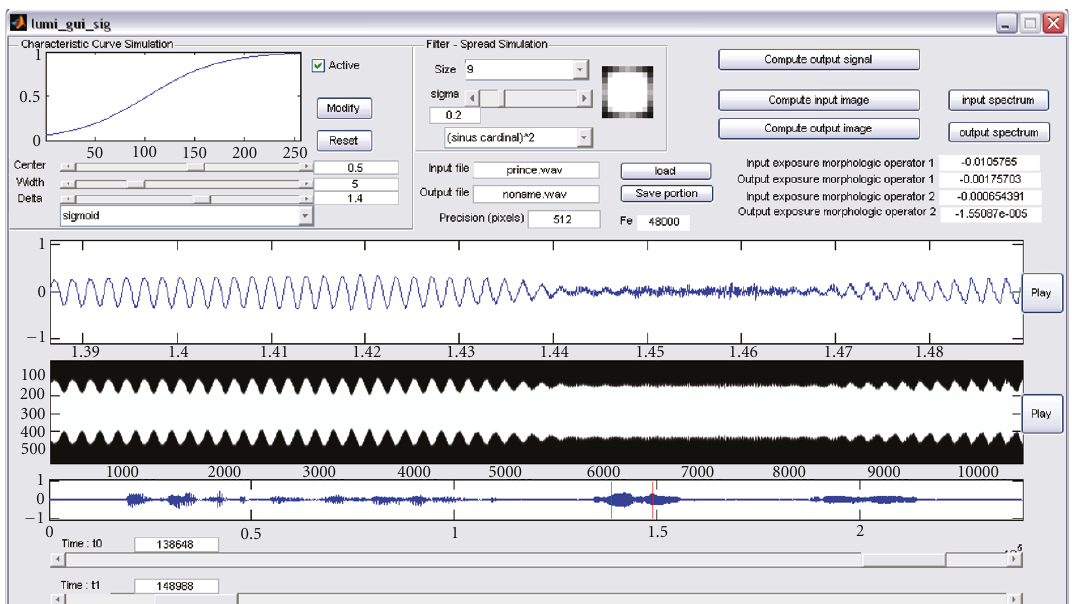
Figure 9: MATLAB user interface of the simulation framework. We are able to load a WAVE sound, convert it into its optical representation, simulate the image spread, and convert the signal back to WAVE. The user may set the width of the image spread function, as well as the exposure condition.